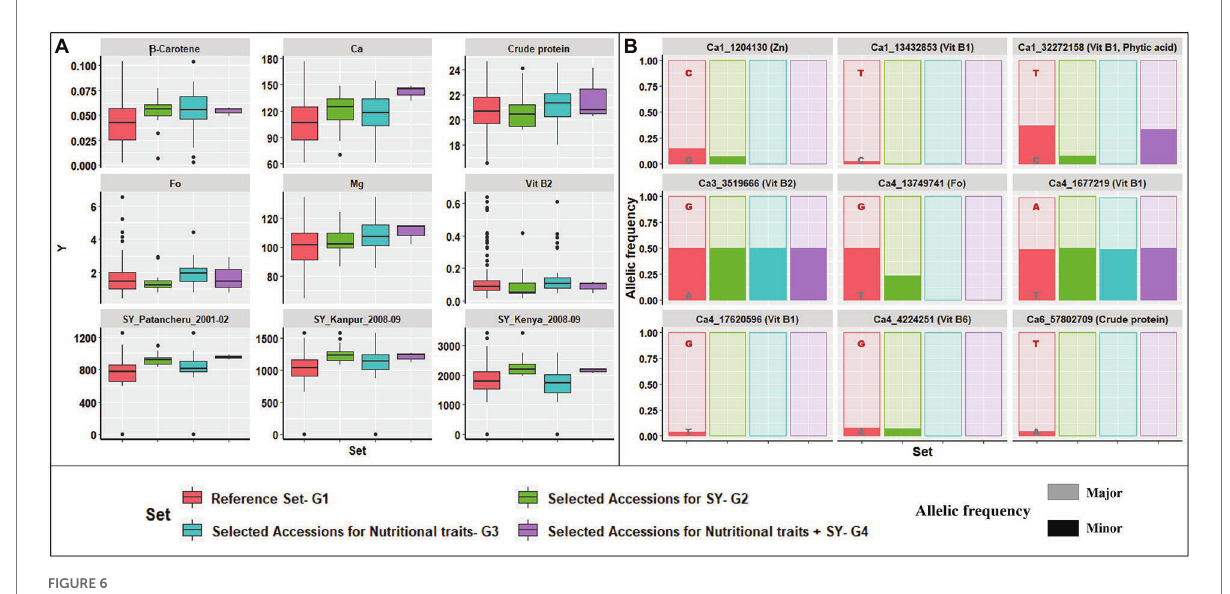
FIGURE 6 Selection strategy for identifying potential donor accessions. (A) Graphical representation of variability in trait content for four groups: G1, reference set; G2, selected accessions for high SY across five seasons and four locations; G3, selected accessions for high nutritional trait range; G4, common accessions from G2 and G3. Comparison of trait range for β -Carotene, Ca, crude protein, Fo, Mg, Vit B2, and SY between three locations, highlighting that G4 accessions had a narrow range and comparable or higher mean than G1. (B) Variation in the major and minor allelic frequencies for the nine loci detected significance for six traits within the reported genes for G1–G4. The major allele was dominant for selected accessions in G2, G3, and G4, compared to the reference set,